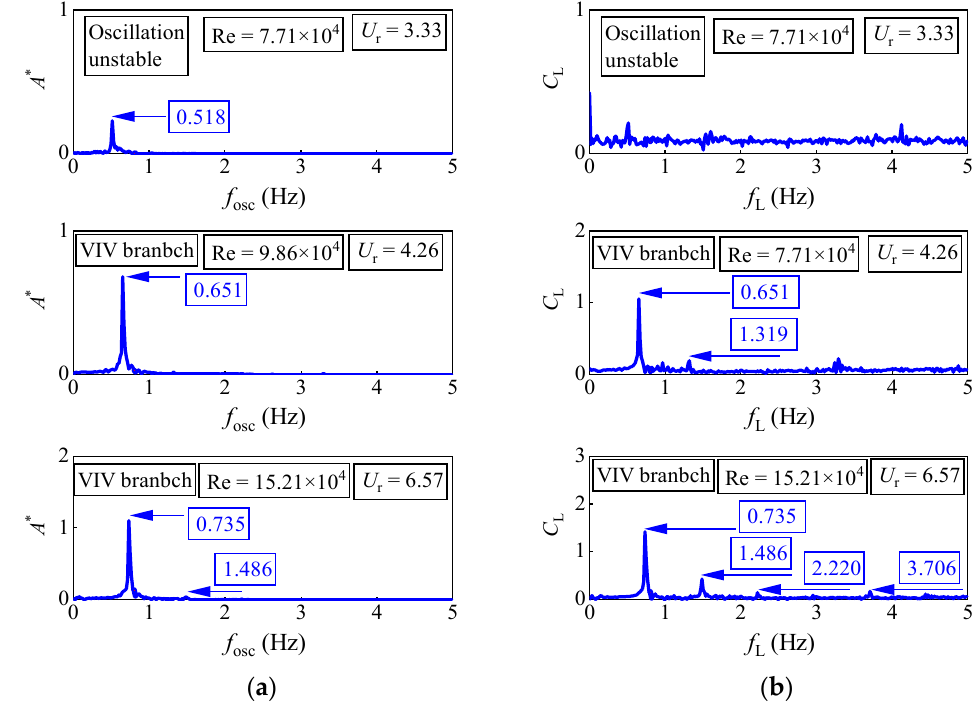
Figure 17. Spectral of Cir-T-Att with D = 0.16 m, R e = 7.71 × 10 4 ~1.84 × 10 5 . ( a ) Displacement spec-